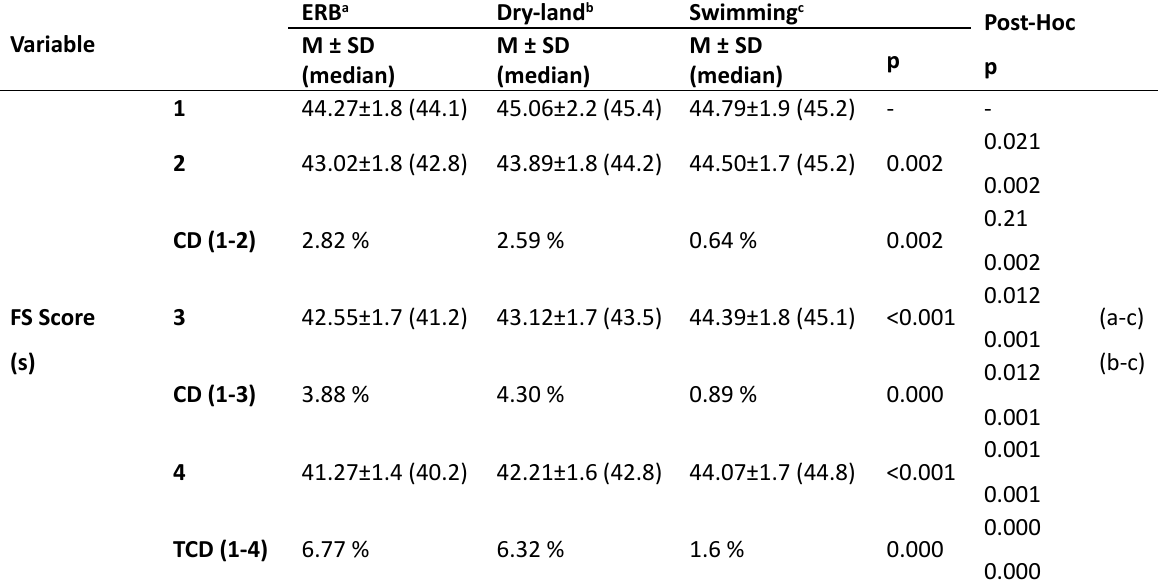
Table 4. The FS performance as based on the assessment times and total change difference.